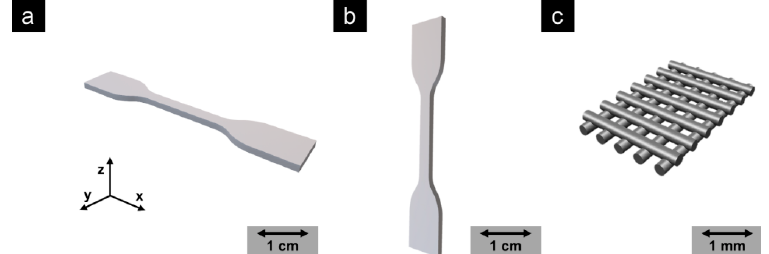
Figure 4. Illustration of the different printing orientations for the mechanical characterization: ( a ) x-y printing; ( b ) x-z printing direction; ( c ) illustration of the crossed linear ±45° 3D printing infill orientation used for reliable mechanical